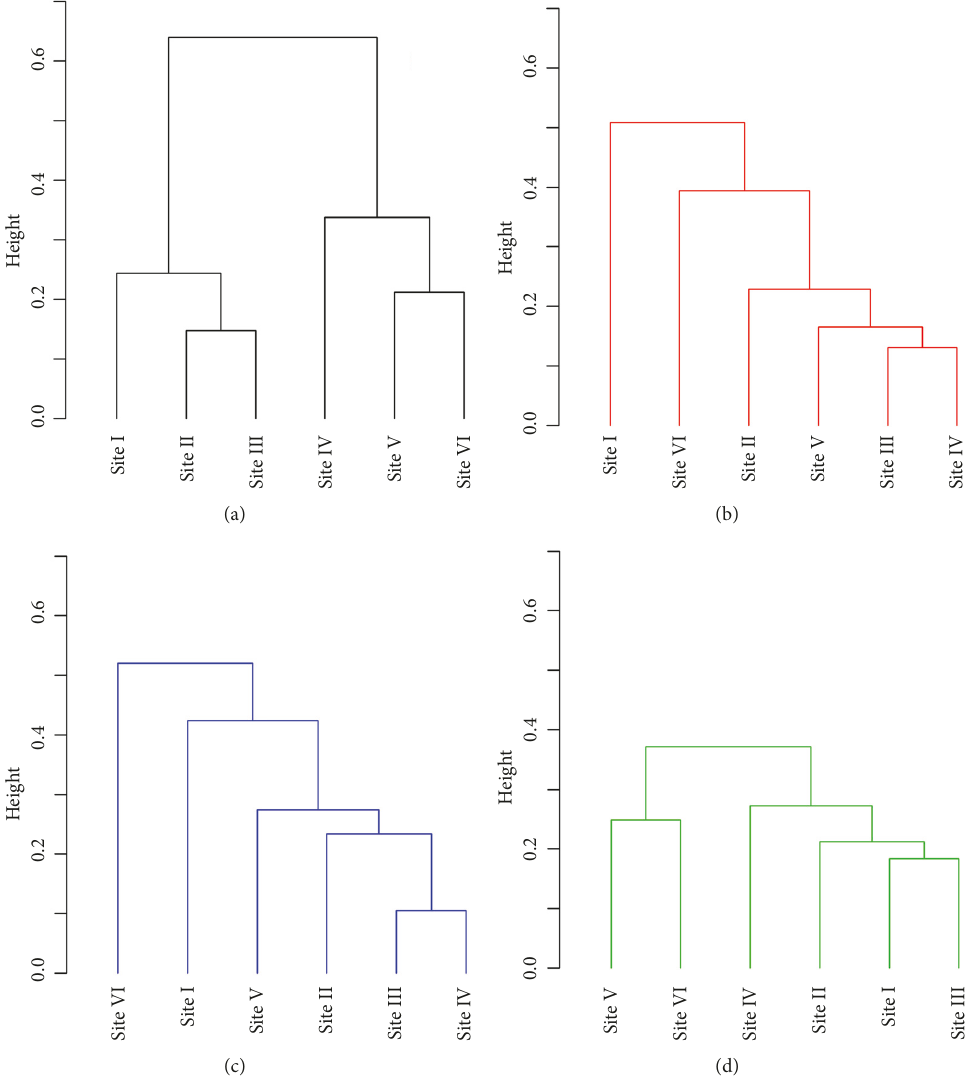
Figure11:Multivariateagglomerativeclustering(WardD.2grouplinkage)basedonBray-Curtisdistance(speciesIVIdissimilarities)between the studied sites. (a) Janajagaran BZCF, (b) Musharni Mai BZCF, (c) Radha Krishna BZCF, and (d) Parsa Wildlife